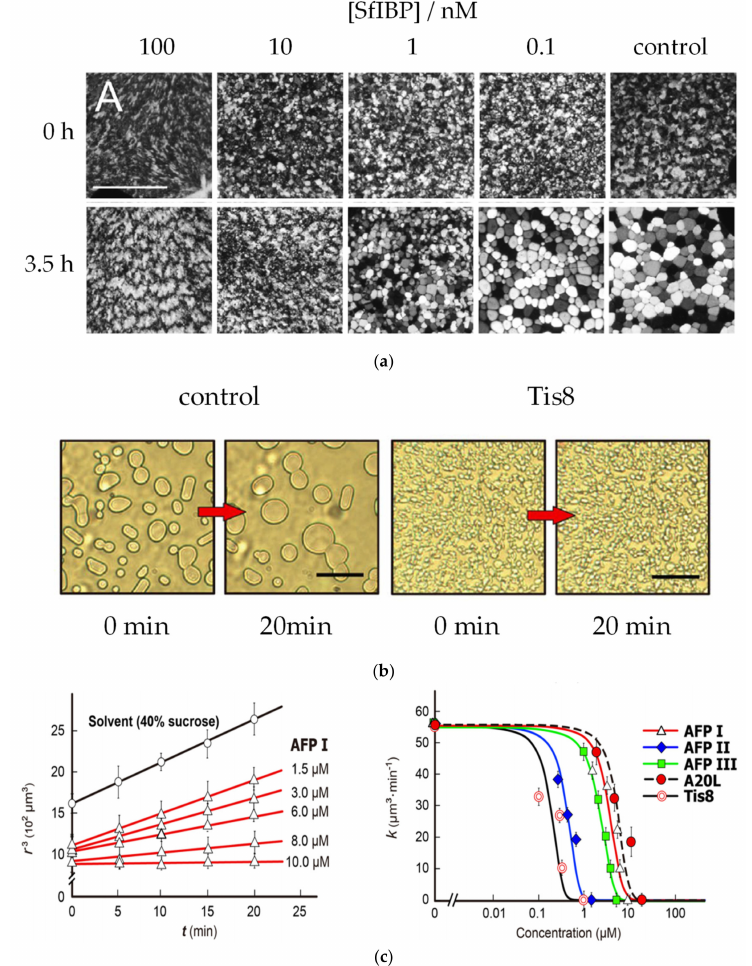
Figure 7. Overview of IRI assays. ( a ) Endpoint analysis of samples containing 100 nM of ice-binding proteins from Spodoptera frugiperda ( Sf IBP) compared to a bu ff er as reference sample. Crystal growth